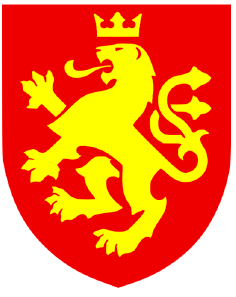
Figure 10. Proposal with lion by Miroslav Grchev.